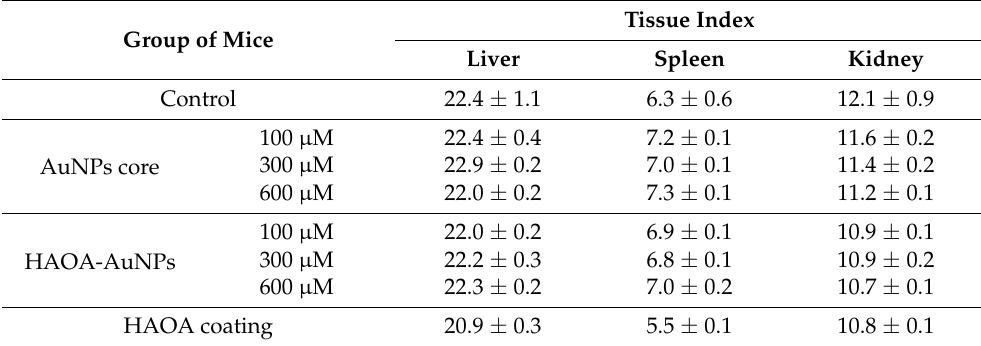
Table 2. Average of tissue indexes (liver, spleen and kidneys) of each group of Balb/c mice 24 h post-i.v. administration of different formulations at different doses. Control represents the tissue indexes of animals injected with PBS.